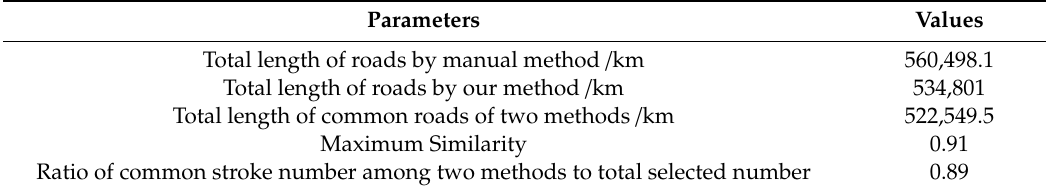
Table 7. Statistics of maximum similarity and its related parameters.